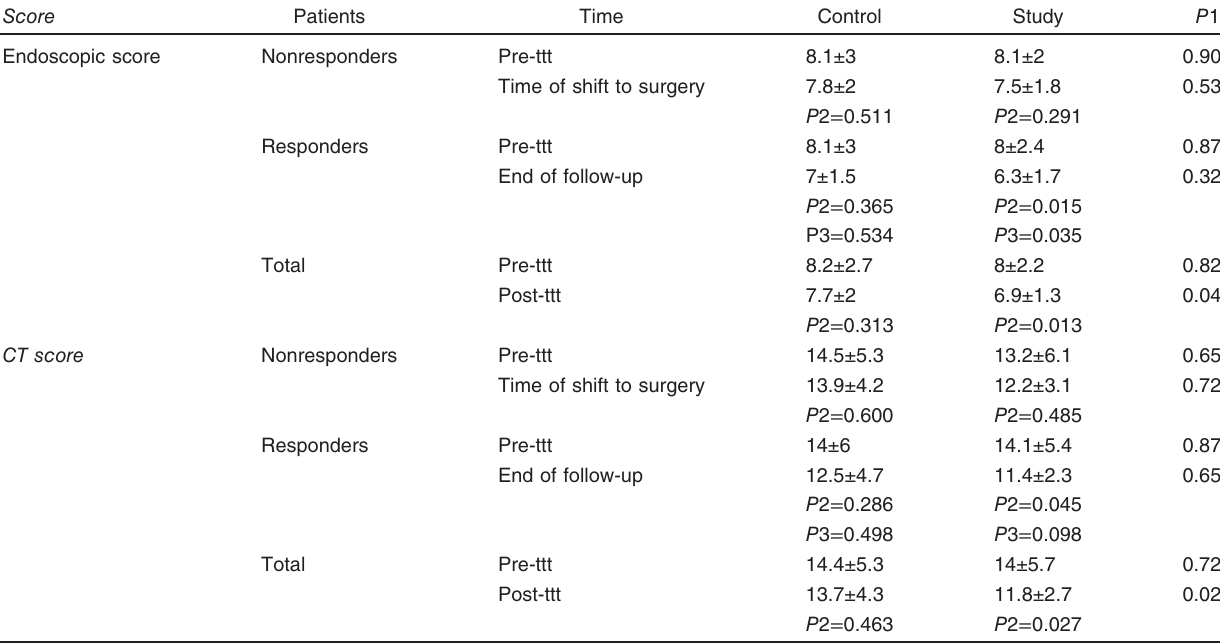
Data are shown as mean±SD. ttt, treatment. P 1: indicates significance of difference between scores of both groups. P 2: indicates significance of difference between pre-ttt and post-ttt scores. P 3: indicates significance of difference between pre-ttt and post-ttt at 12- month